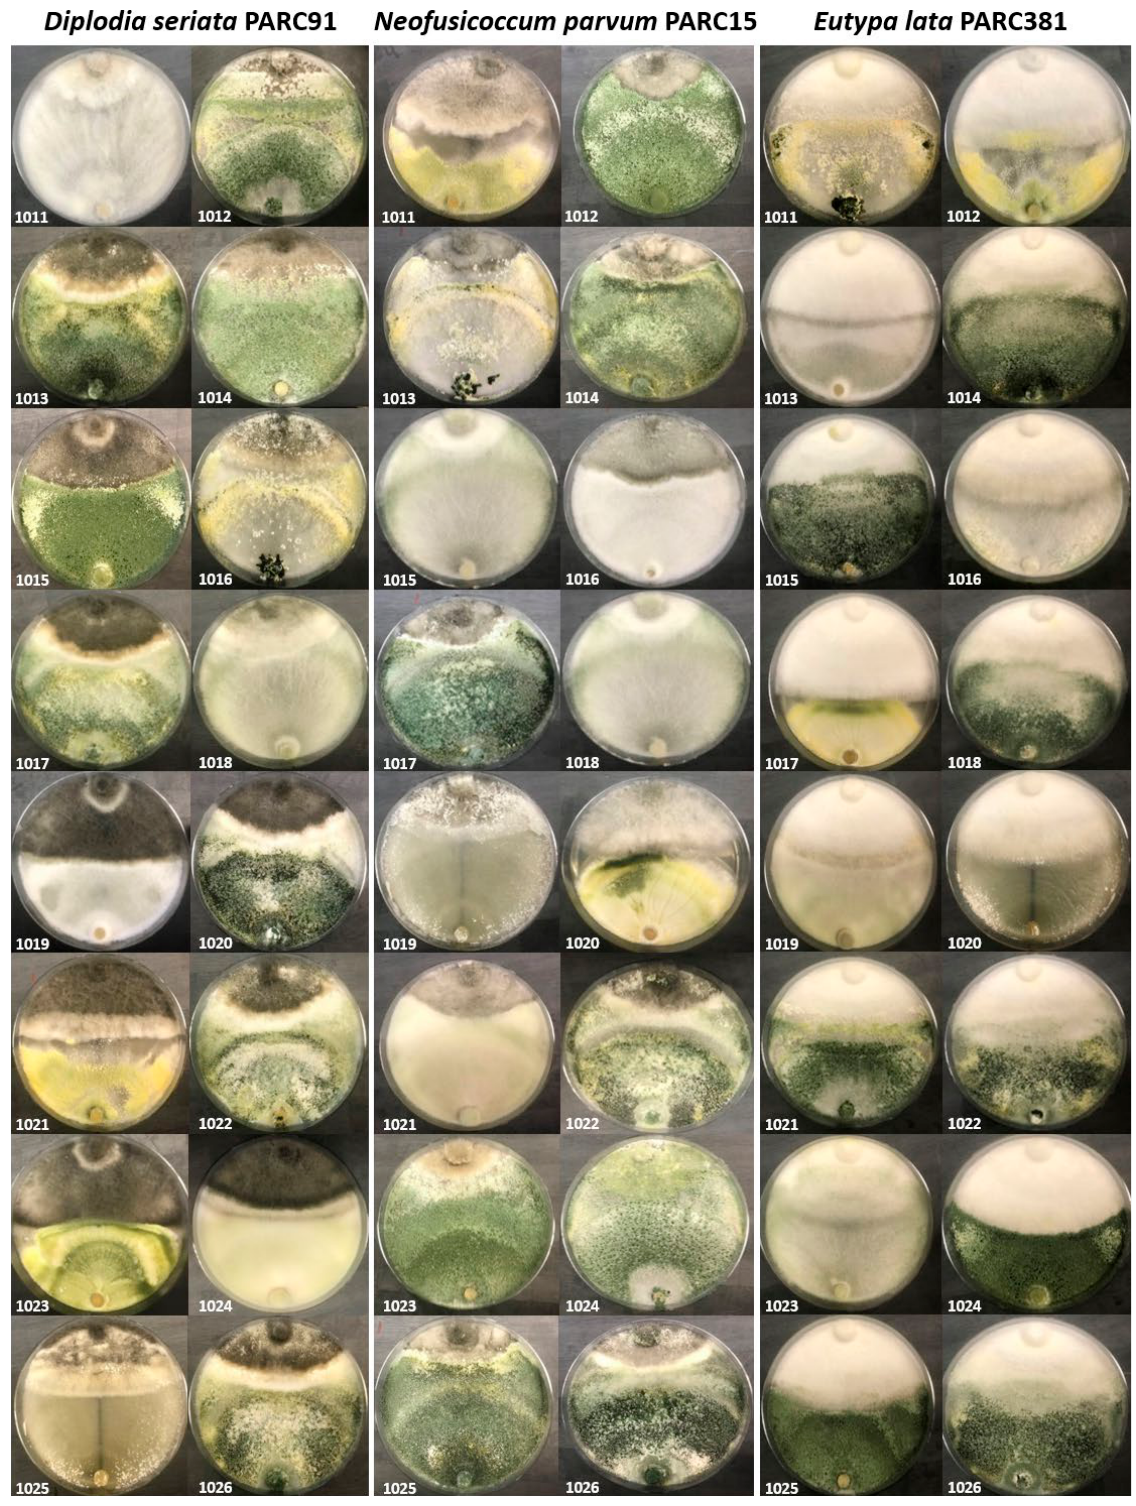
Figure 5. Dual culture antagonism experiment. Petri plates show antagonistic activity of each Trichoderma isolate used in this study (bot- tom side of Petri dish) against the GTD pathogens Diplodia seriata PARC91, Neofusicoccum parvum PARC15 and Eutypa lata PARC 381 (top of Petri plate) five days after culturing on PDA at 23°C